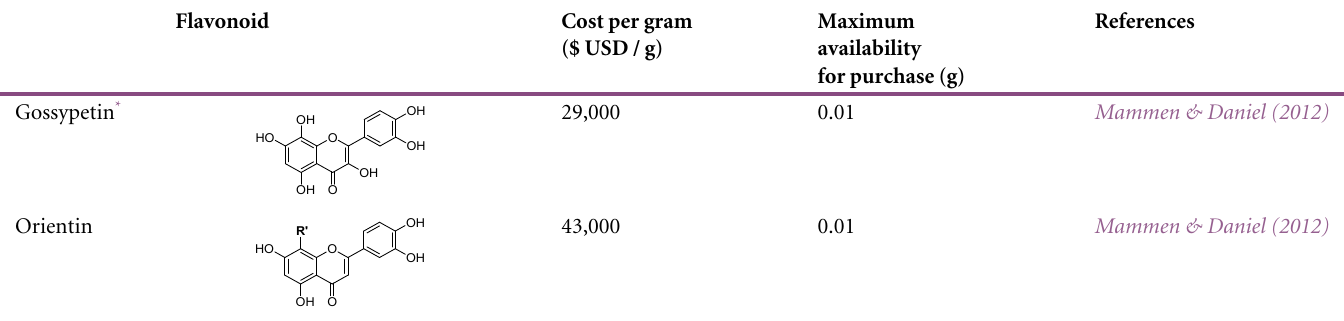
spectra of rutin-aluminum chelation complexes with increasing aluminum concentration and a repre-